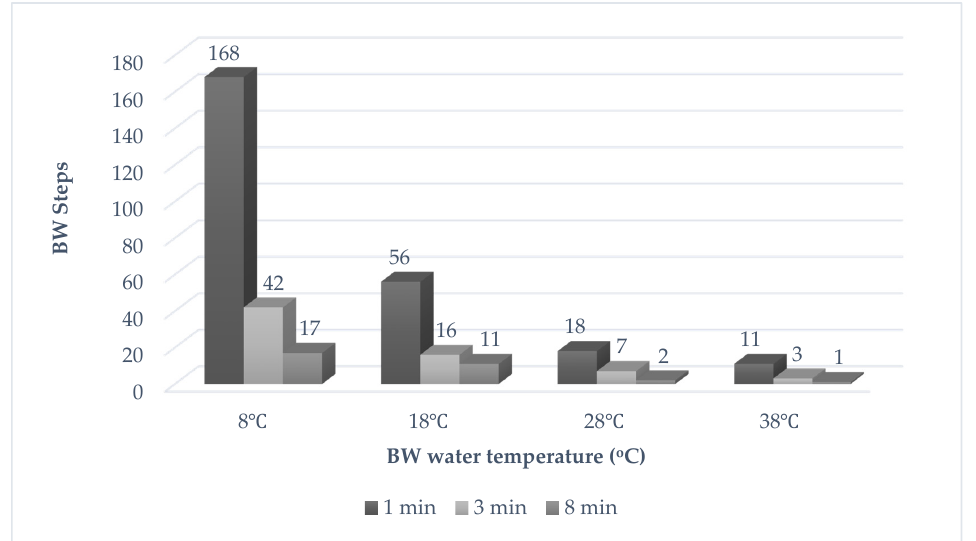
Figure 4. Number of BW steps required for the different water temperature in a period of a week (168 h), for BW duration of 1 min, 3 min and 8 min.